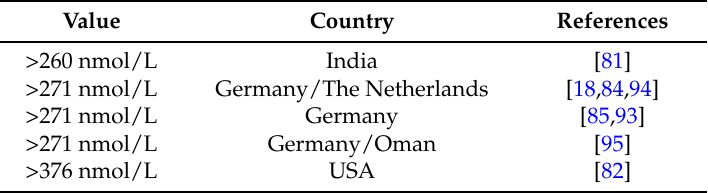
Table 3. Methylmalonic acid values for vitamin B12 deficiency.